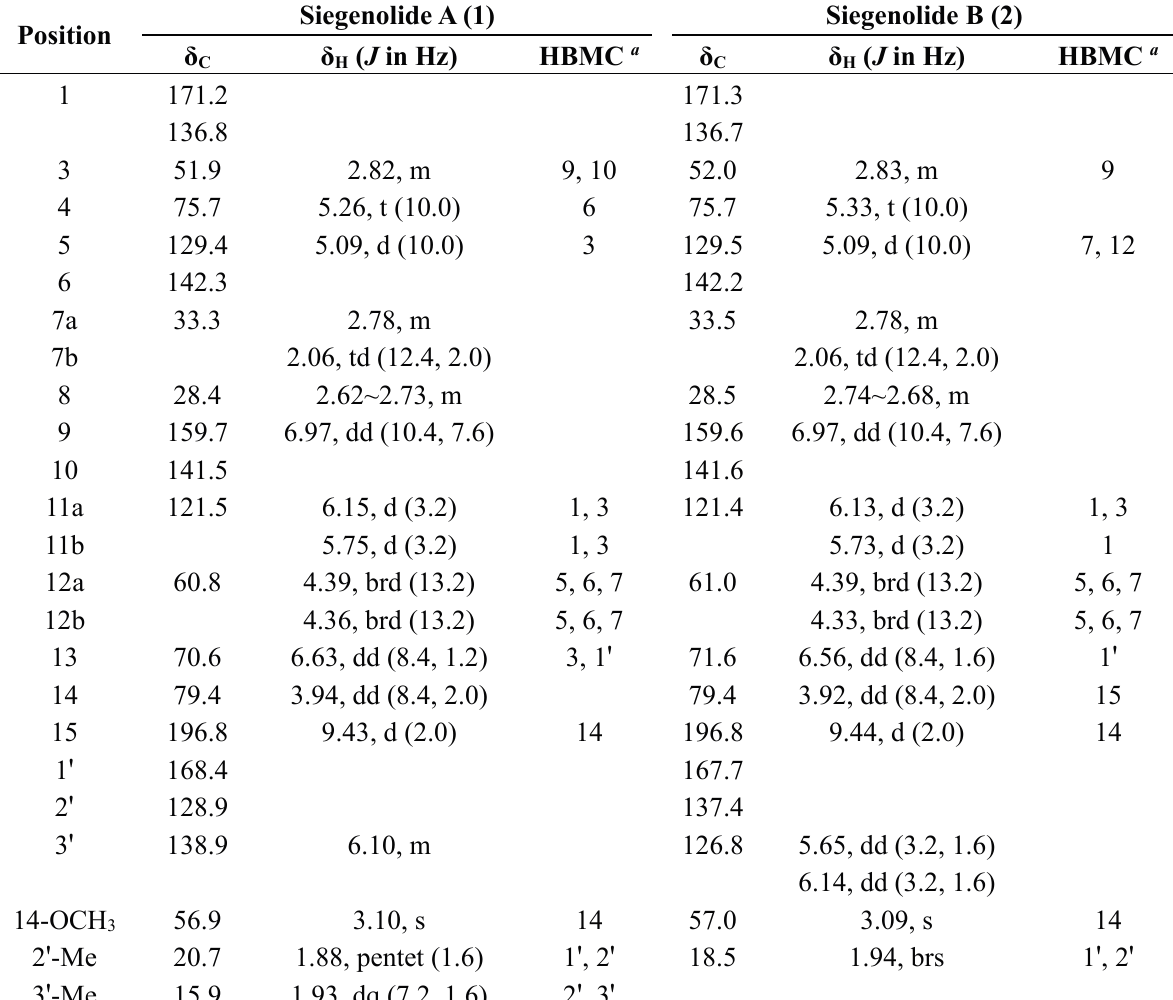
Table 1. NMR Spectroscopic data (400 MHz, CD 3 OD) for siegenolides A ( 1 ) and B ( 2 ). Position